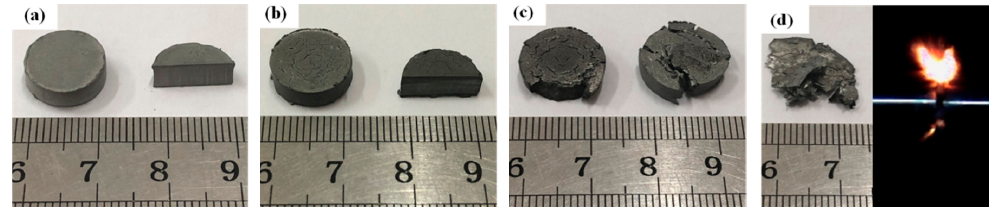
Figure 7. Recovered type B samples after dynamic compression tests at different strain rates: ( a ) 786 s − 1 ; ( b ) 1995 s − 1 ; ( c ) 2767 s − 1 ; ( d ) 3323 s − 1